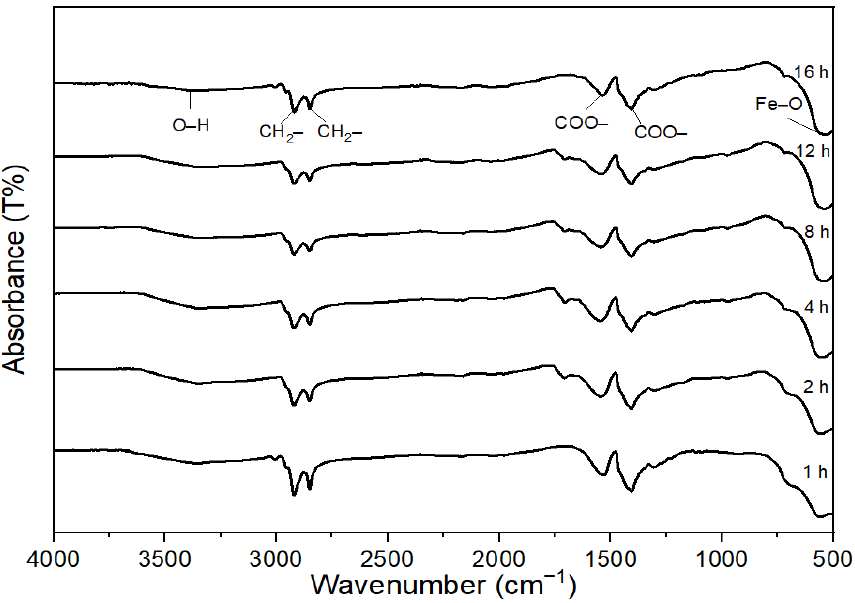
Figure 3. FT-IR spectra of CoFe 2 O 4 nanoparticles synthesized at 180 °C in the presence of 1 M oleic acid for different reaction times.